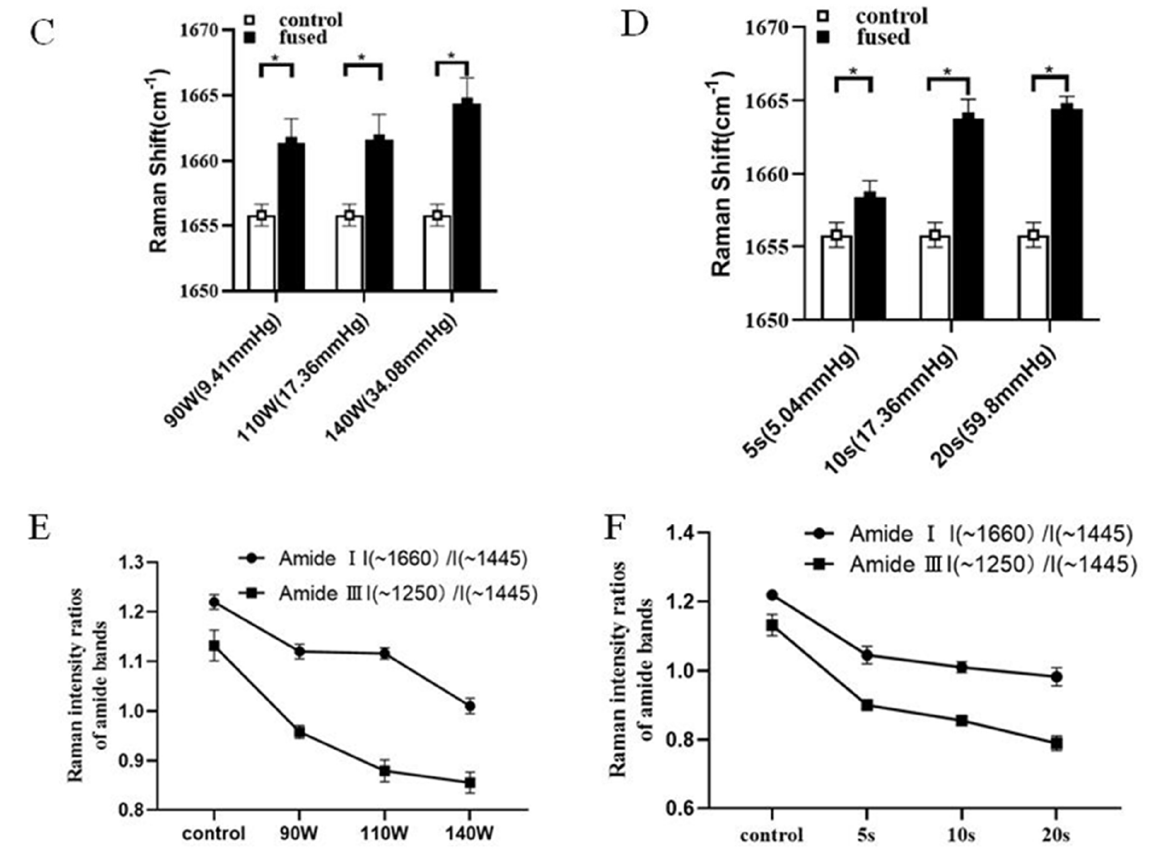
Figure 4. ( A , B ). Mean Raman spectra of control and fused areas mapped in porcine bowel tissue undergoing different Ps and Ts. Raman Shifts of 940 cm − 1 , 1250 cm − 1 , 1443 cm − 1 and 1655 cm − 1 are highlighted corresponding to the protein alpha helix, amide Ⅲ , CH2 wag, and amide Ⅰ . ( C , D ). Peak maximum Raman shift (cm − 1 ) location of amide I in small intestine tissue comparing fused tissue and control tissue. Samples were fused with different Ps and Ts. The corresponding average burst pressure is in parentheses, * p -value<0.05. ( E , F ). Raman intensity ratios of amide I( ~ 1660 cm − 1 )/I ( ~ 1445 cm − 1 ) and amide Ⅲ I( ~ 1250 cm − 1 )/I( ~ 1445 cm − 1 ) in the small intestine’s fused area, undergoing different Ps and Ts.